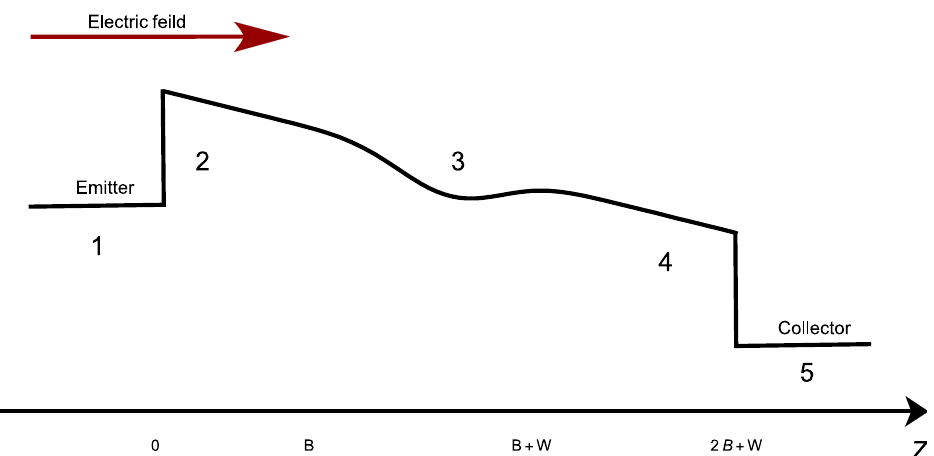
Figure 1. Schematic diagram of the InGaN/GaN parabolic QW LED structures under a uniform applied electric field.